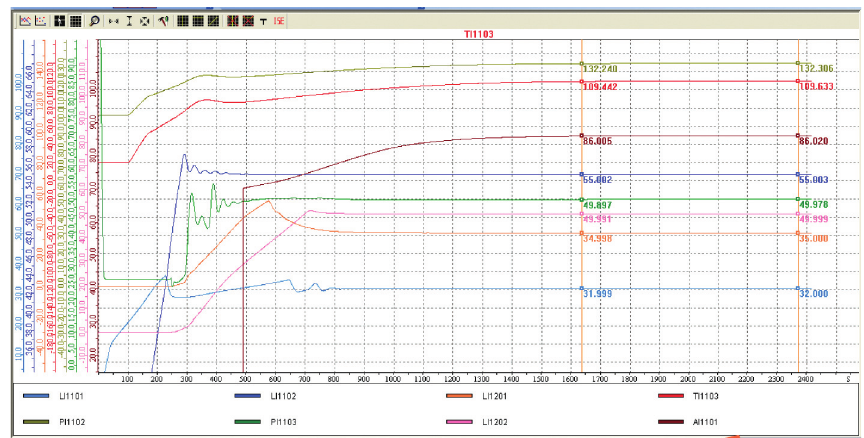
Figure 10: Trend graph of improved automatic disturbance rejection control.